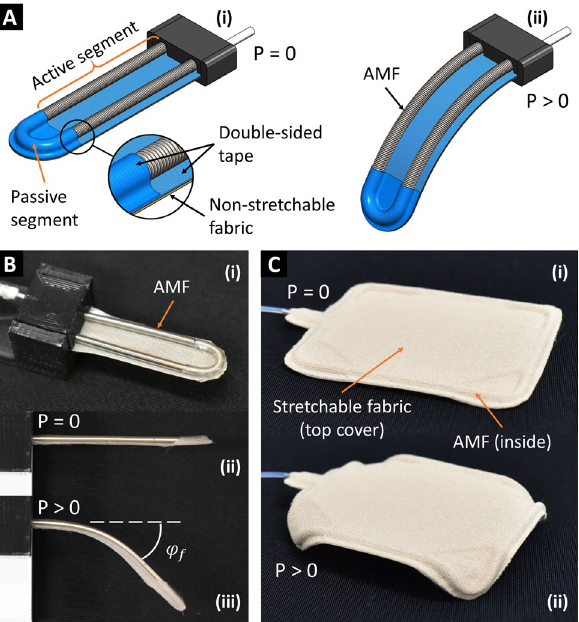
Figure 3. Fabric reconfiguration by sticking AMFs to conventional fabrics. ( A ) Design concept of bending actuators made by sticking a folding AMF to a non-stretchable fabric. ( B ) Bending actuator prototype. ( C ) Reconfiguring a rectangular fabric into an active four-legged robot. Non-stretchable fabric: plain-woven cotton muslin; stretchable fabric: polyester. Detailed specifications can be found in the “Methods”